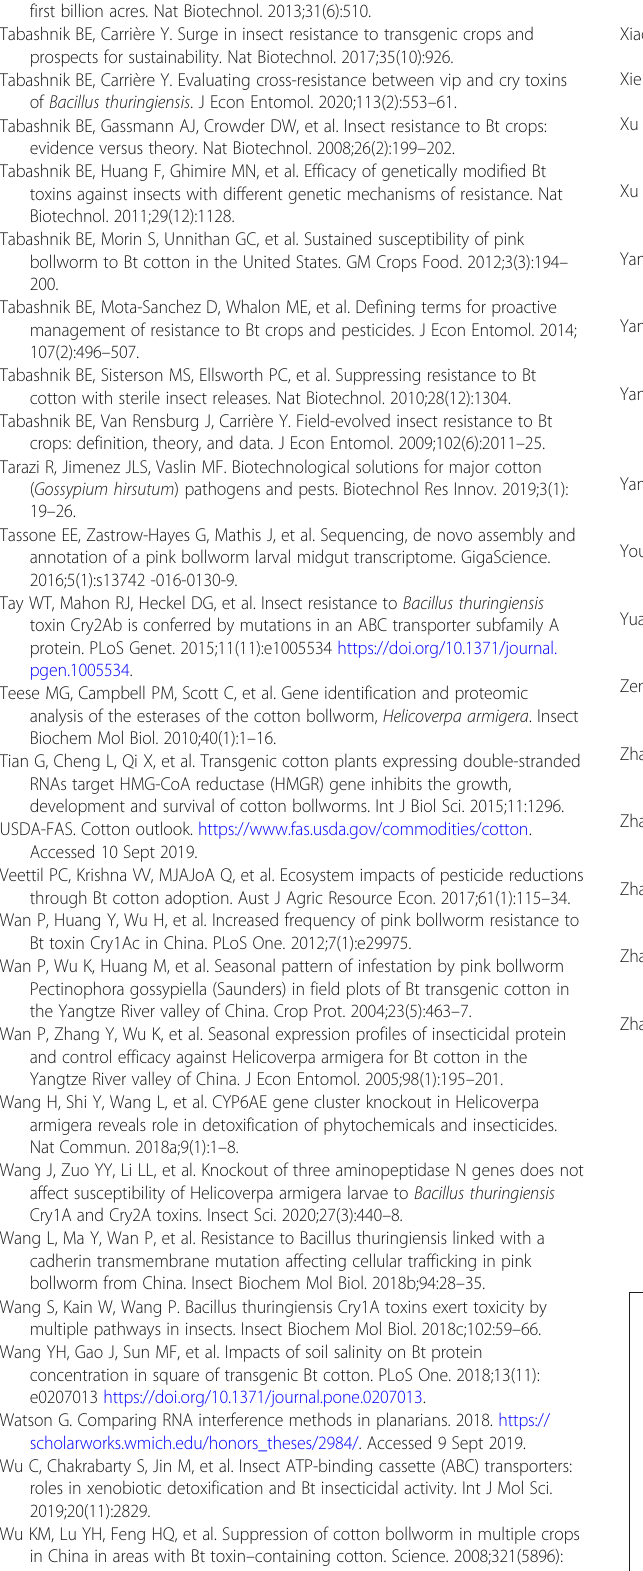
Tabashnik BE, Brévault T, Carrière Y. Insect resistance to Bt crops: lessons from the first billion acres. Nat Biotechnol. 2013;31(6):510. Tabashnik BE, Carrière Y. Surge in insect resistance to transgenic crops and prospects for sustainability. Nat Biotechnol. 2017;35(10):926. Tabashnik BE, Carrière Y. Evaluating cross-resistance between vip and cry toxins of Bacillus thuringiensis . J Econ Entomol. 2020;113(2):553 – 61. Tabashnik BE, Gassmann AJ, Crowder DW, et al. Insect resistance to Bt crops: evidence versus theory. Nat Biotechnol. 2008;26(2):199 – 202. Tabashnik BE, Huang F, Ghimire MN, et al. Efficacy of genetically modified Bt toxins against insects with different genetic mechanisms of resistance. Nat Biotechnol. 2011;29(12):1128. Tabashnik BE, Morin S, Unnithan GC, et al. Sustained susceptibility of pink bollworm to Bt cotton in the United States. GM Crops Food. 2012;3(3):194 – 200. Tabashnik BE, Mota-Sanchez D, Whalon ME, et al. Defining terms for proactive management of resistance to Bt crops and pesticides. J Econ Entomol. 2014; 107(2):496 – 507. Tabashnik BE, Sisterson MS, Ellsworth PC, et al. Suppressing resistance to